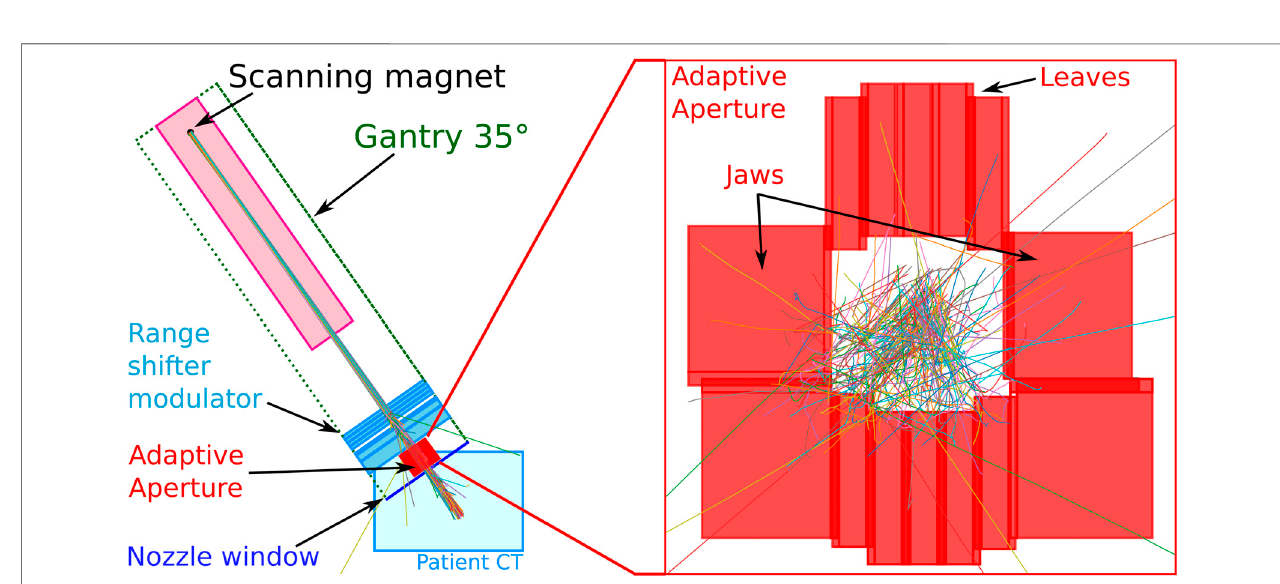
FIGURE 2 | Elements of the beam